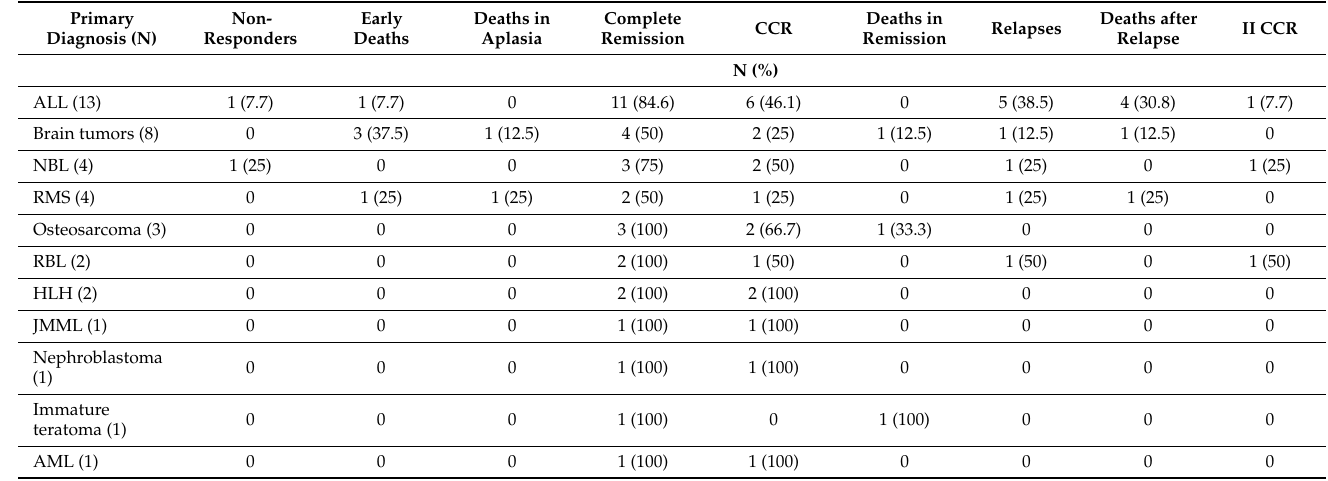
Immature teratoma (1) ALL—acute lymphoblastic leukemia, NBL—neuroblastoma, RMS—rhabdomyosarcoma, RBL—retinoblastoma, HLH—hemophagocytic lymphohistiocytosis, JMML—juvenile myelomonocytic leukemia, AML—acute myeloid leukemia, CCR—continuous complete remission.